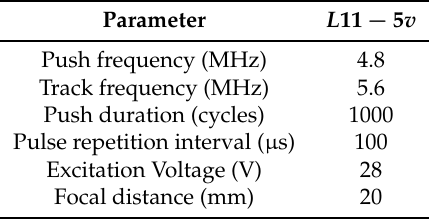
Table 4. SWEI acquisition parameters for L 11 − 5 v Verasonics transducer.